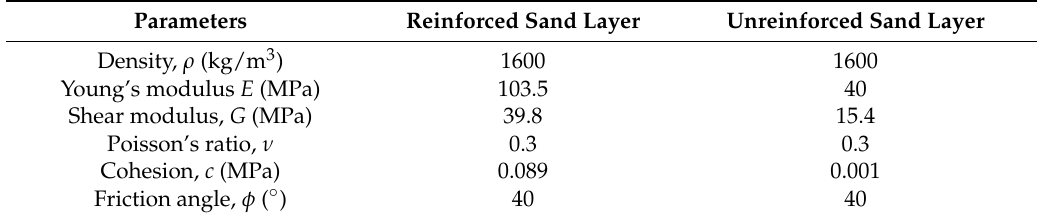
Table 10. Material properties of the foundation